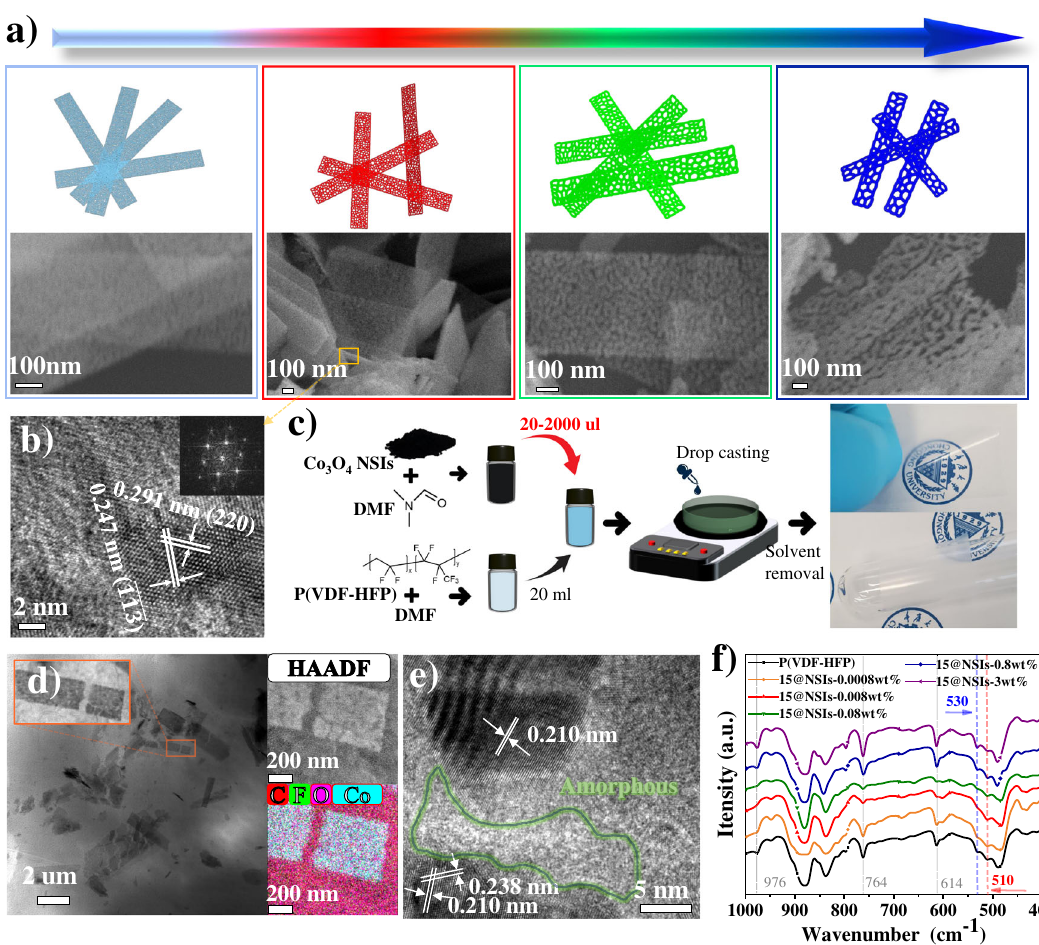
Fig. 1 | Material preparation and characterization. a Diagram (top) and SEM (bottom) images of the Co 3 O 4 nano-sieves (NSIs) with 5, 15, 25, and 50nm pore diameter (left to right). b HRTEM image of NSIs with 15nm pore size. The lattice fringe spacings of 0.291 and 0.247nm correspond to the (220) and ( (cid:1) 1 (cid:1) 1 (cid:1) 3) crystal planes, respectively, indicating that the (1 (cid:1) 10) and (110) zone axes have